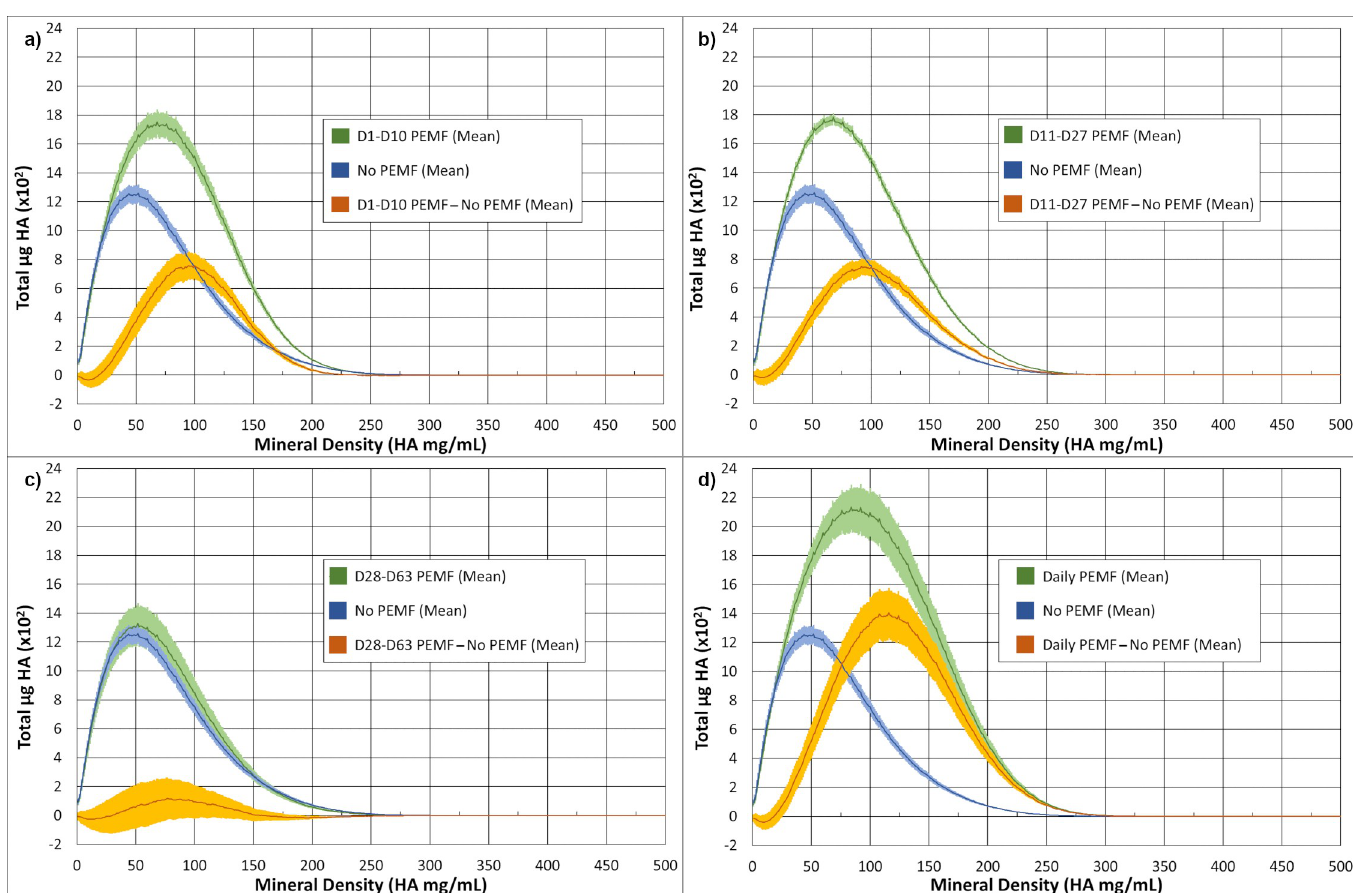
Fig 7. Micro-CT-derived density profiles at Day 27. Total HA vs. HA mg/ml was plotted, and profiles compared between no-PEMF controls and PEMF treatment between Day 1- Day 10 (a); PEMF between Day 11-Day 27 (b); PEMF between Day 28-Day 63 (c); and Daily PEMF (d). In each case, n = 3 and the lines are the means, and thicknesses represent the standard error. Control values were also subtracted from PEMF values at each density to yield a difference plot (orange) to visualize the effect of PEMF on mineral density.